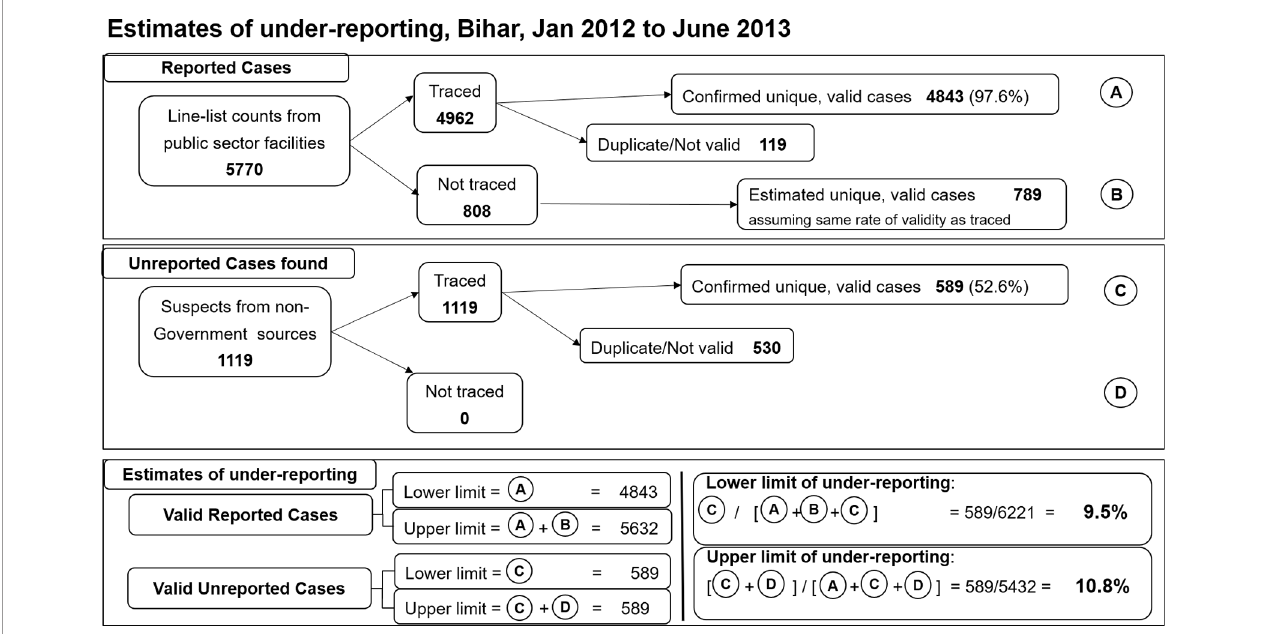
FIGURE 3 | Estimates of visceral leishmaniasis under-reporting, 8 districts of Bihar, January 2012-June 2013. A total of 5770 cases were extracted from the line list of visceral leishmaniasis cases treated at public sector facilities during the study period, of which 4962 were traced and 4843 of those validated (A) . Assuming the untraced cases had the same rate of validity as the traced cases yields an additional 734 potentially valid cases (B) . From non-government sources, all 1119 suspected cases were traced and 589 validated as unreported cases (C) . There were no untraced cases (D) . Based on these data, the validated case fi gure was estimated to range between 4843 and 5632 (A to A+B), while unreported case fi gure was 589 (C; D=0). Using the extremes of these estimated ranges, underreporting was estimated between 9.5% and